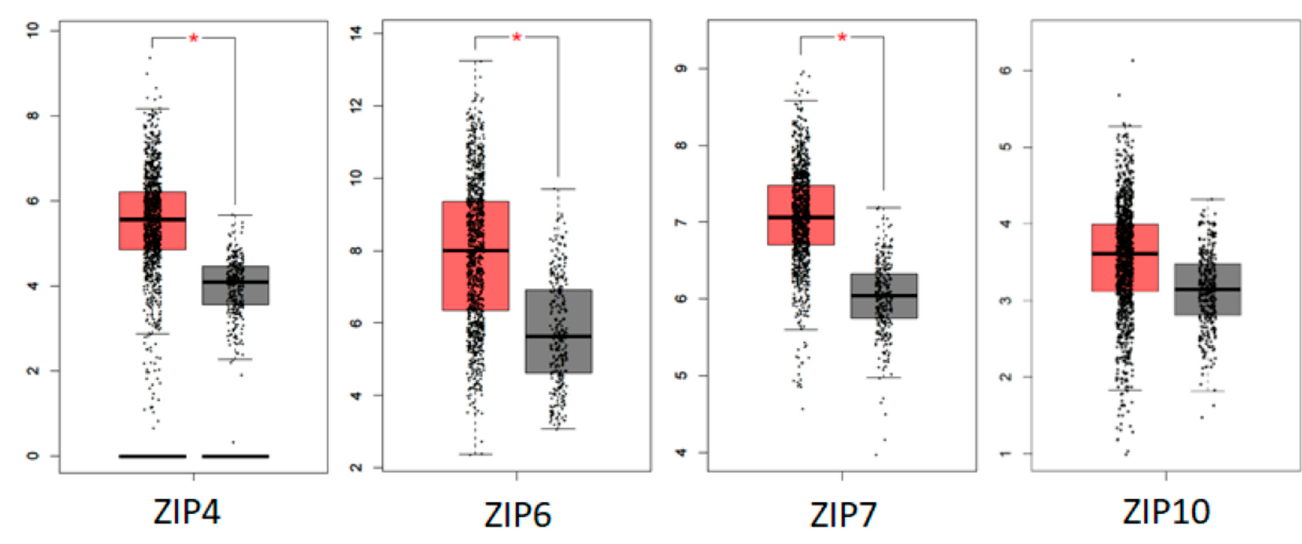
Figure 6. LIV-1 family members that are increased in invasive breast carcinoma tissues. This analysis was performed using Gepia [63] comparing the gene levels in 1085 tumors to 291 normal samples as transcripts per million. ZIP4, ZIP6 and ZIP7 all showed a statistically significant increase in breast tumor samples (red) compared to normal tissues (grey). ZIP10 levels also appeared to increase in the tumors but not significantly. The remainder of the LIV-1 family members did not show any increase and were excluded. * p <